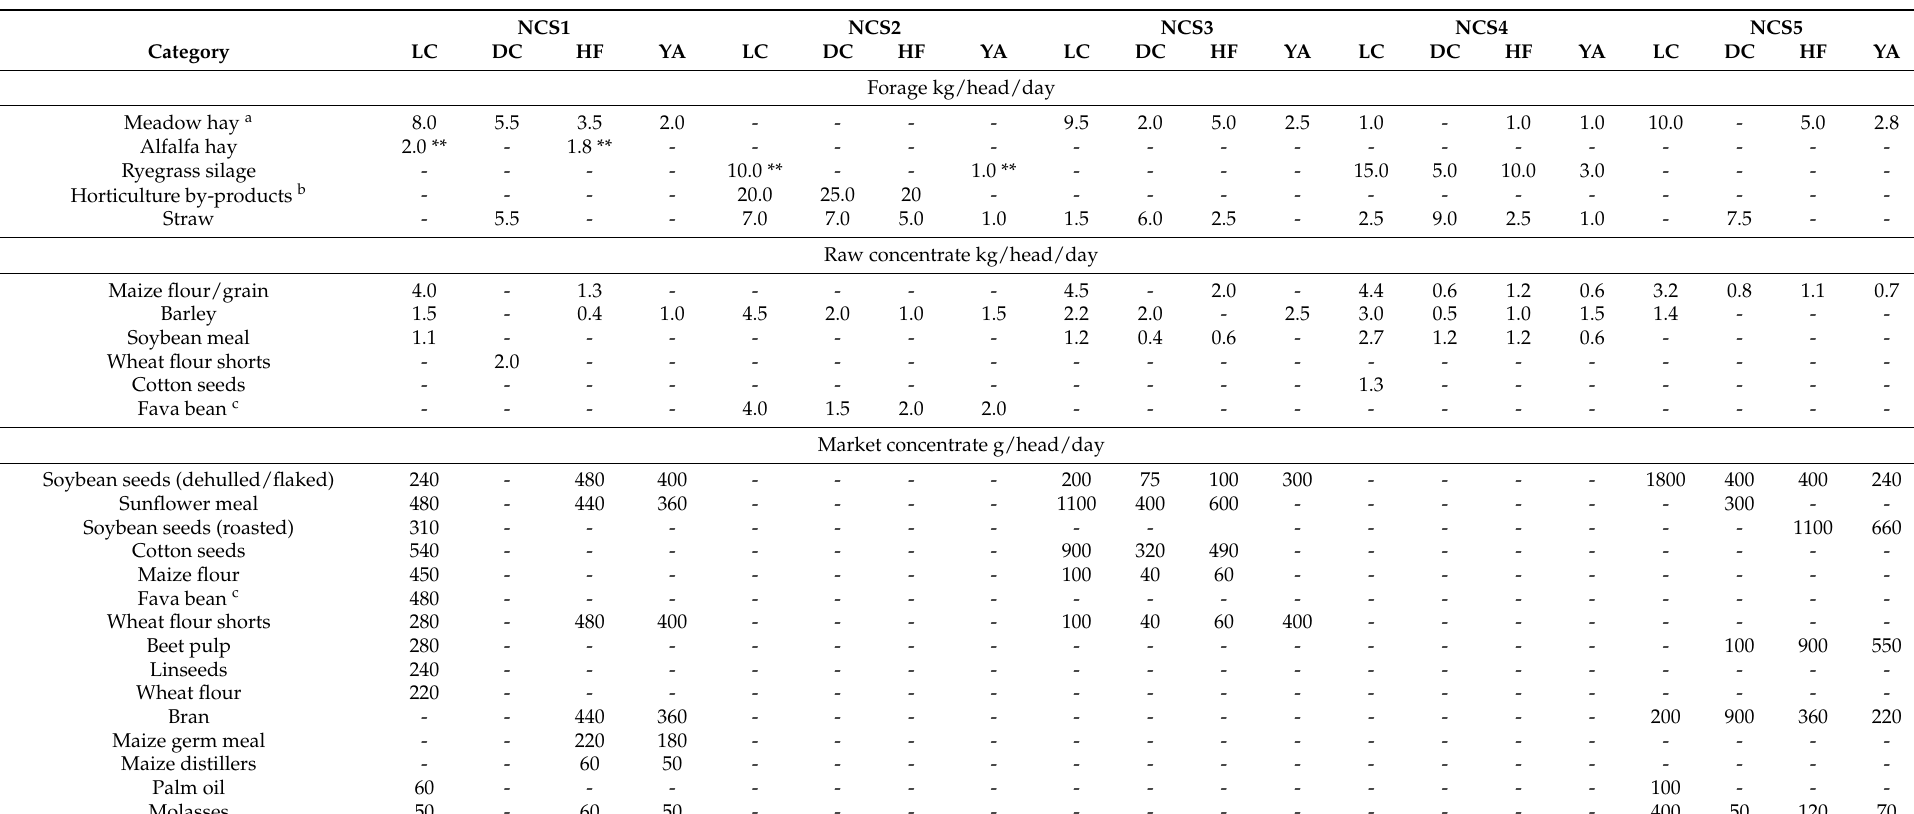
Table 3. Non-corn silage (NCS)